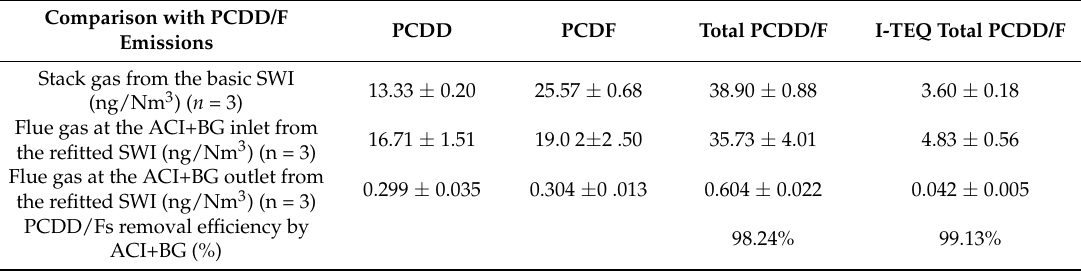
Table 4. Comparison with PCDD/F emissions from the refitted SWI ( n : sampling times). Comparison with PCDD/F